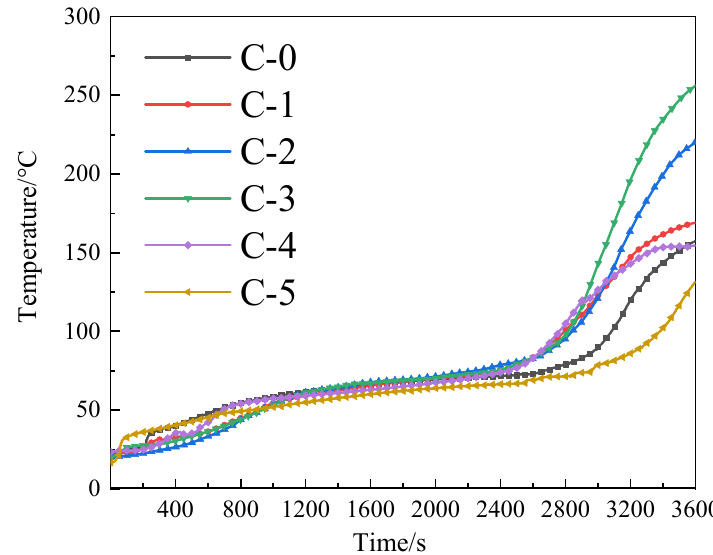
Figure 5. Backside temperature curves of the transparent flame ‐ retardant hydrogels.